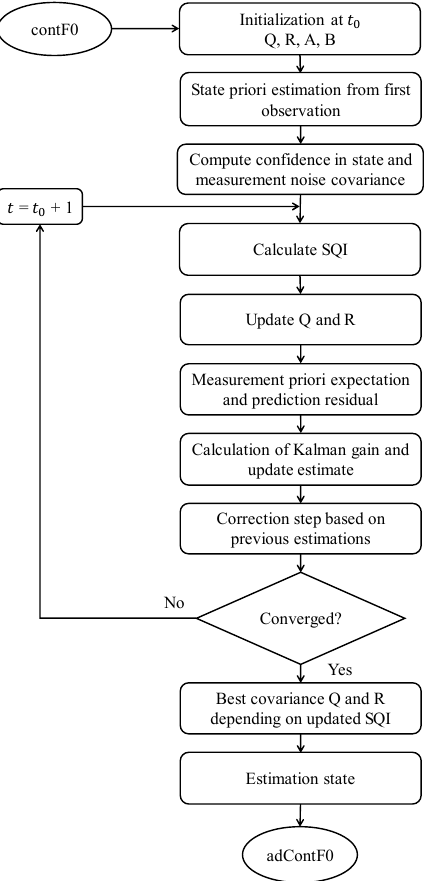
Figure 1. Structure chart of adaptive Kalman filter-based contF0 (adContF0).